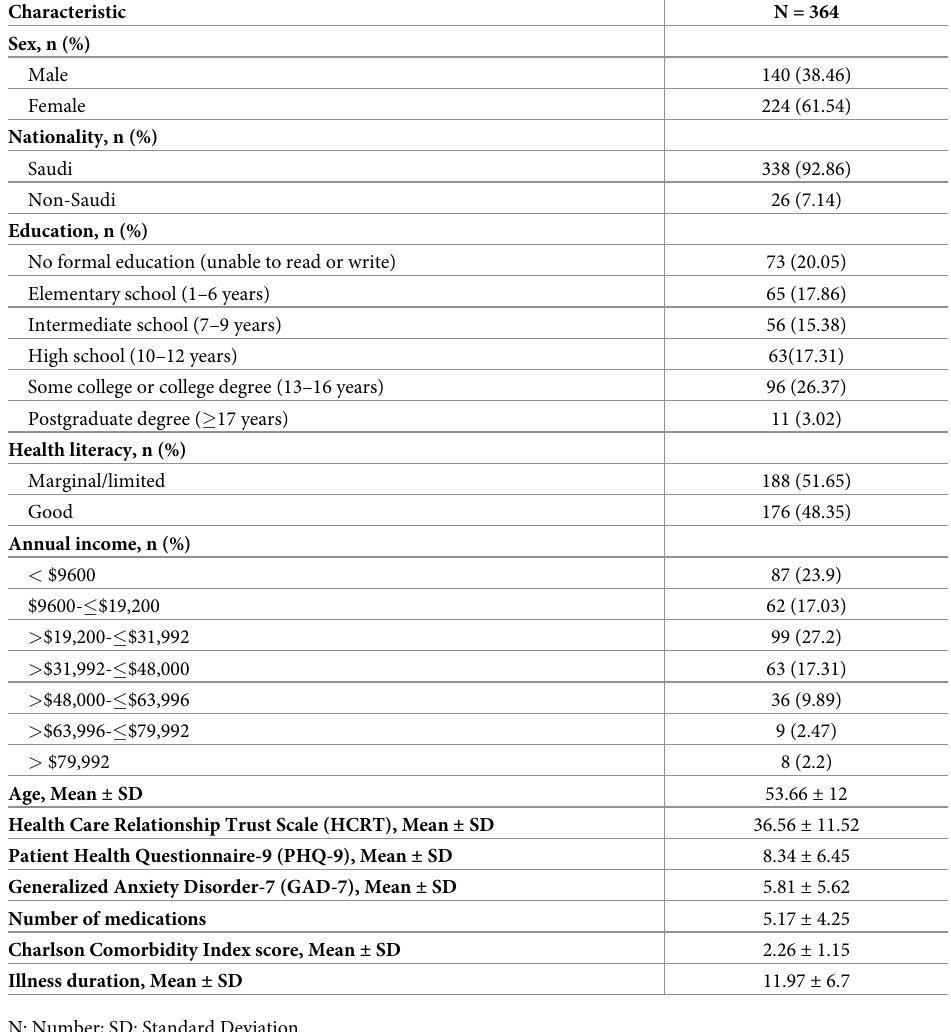
Table 1. Baseline characteristics of the patients with